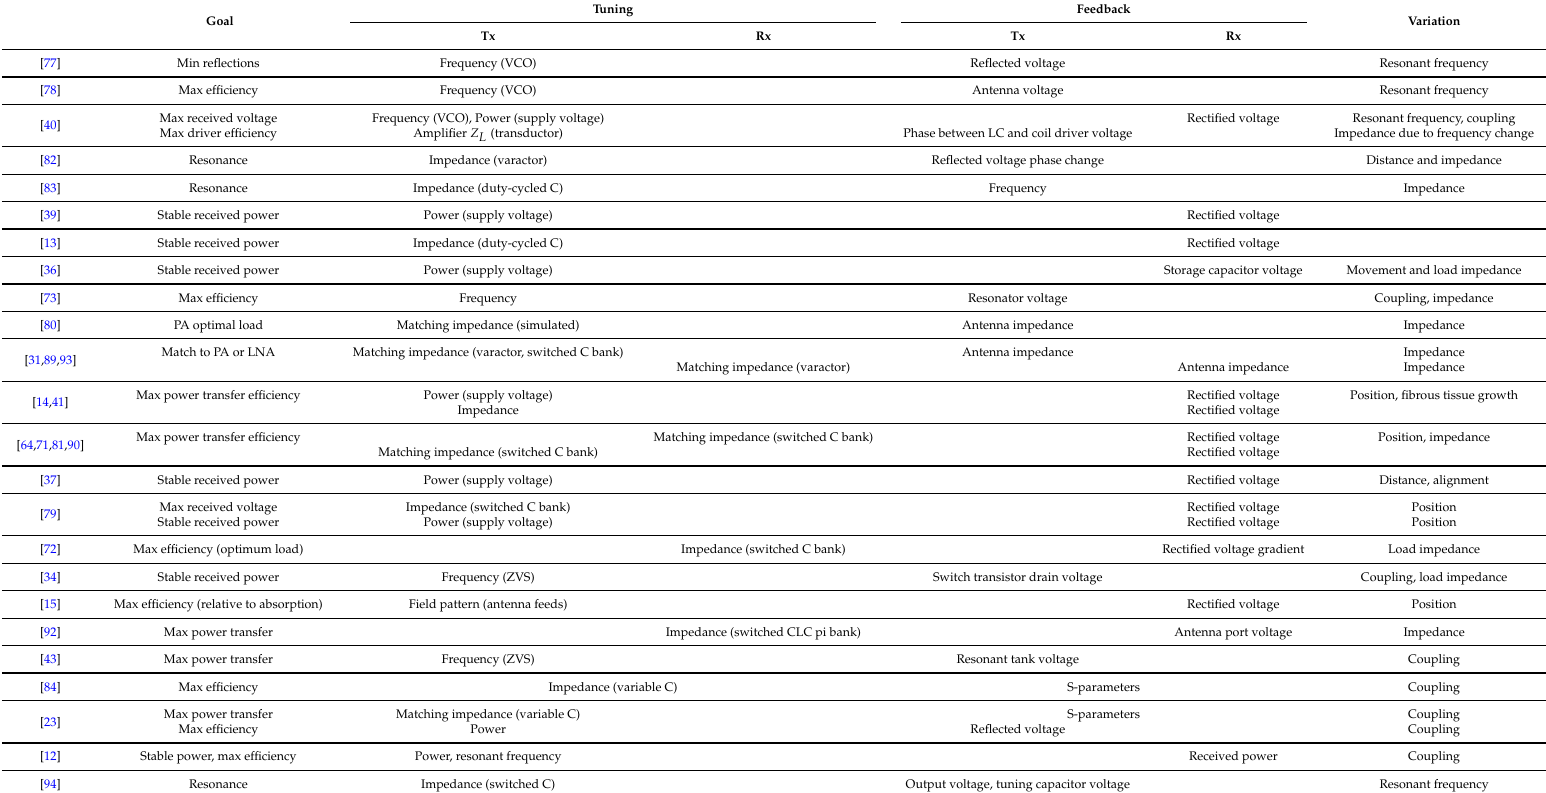
Table 1. Summary of literature on adaptive transcutaneous